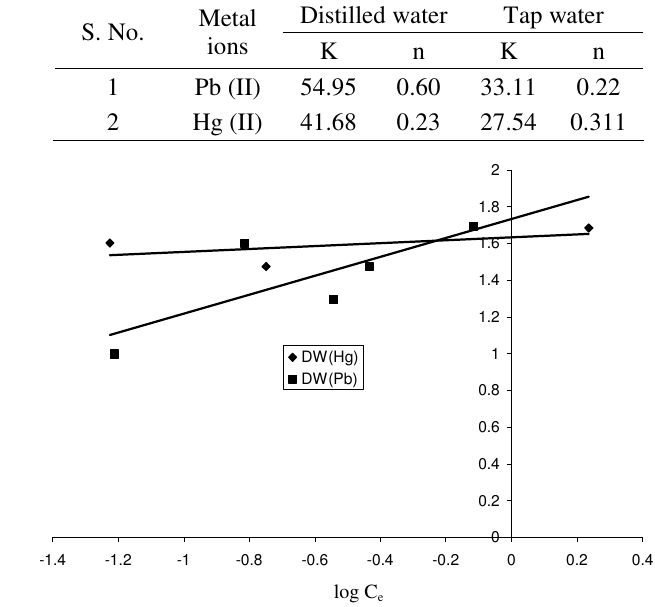
Figure 9 . Freundlich adsorption isotherm in distilled water.